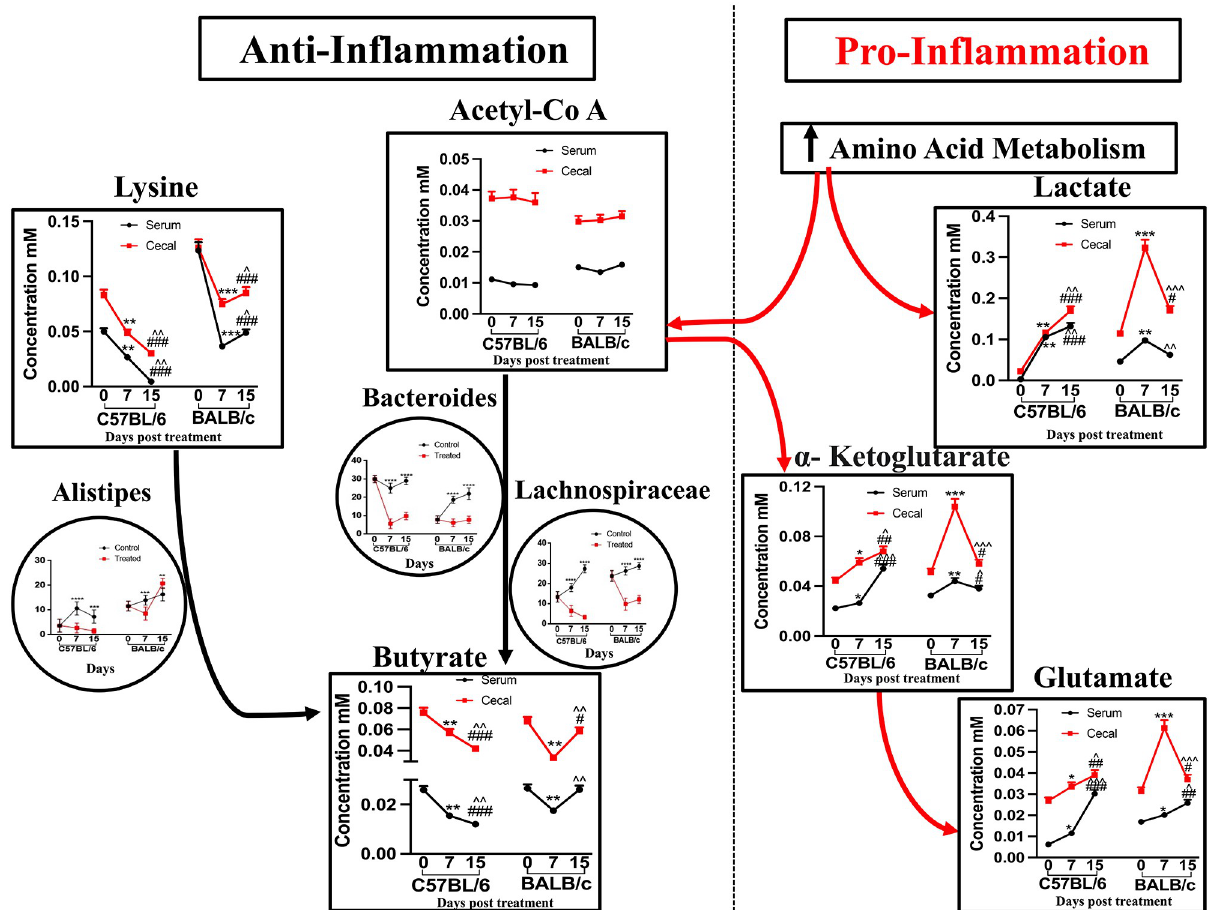
Fig 5. A predictive schema of different regulatory metabolic pathways and associated microbial genus contributing to the varied inflammatory condition at different severity levels of the disease in C57BL/6 and BALB/c mice. We performed Two-way ANOVA followed by the Bonferroni test to determine the significance level. � /#/^ corresponds to P < 0.05, �� /##/^^corresponds to P < 0.01, ��� /###/^^^ corresponds to P < 0.001, ���� /####/^^^^ corresponds to P < 0.0001. � symbolizes the comparison between day 0 and day 7, # symbolizes the comparison between day 0 and day 15, ^ symbolizes the comparison between day 7 and day